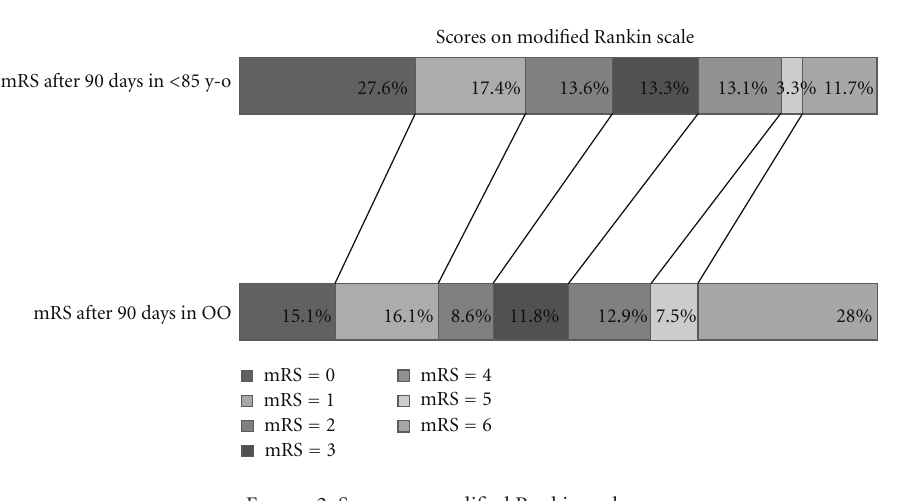
Figure 2: Scores on modified Rankin